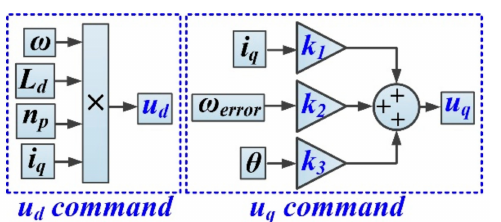
Figure 2. Schematic representation of the LQR controller: u d and u q